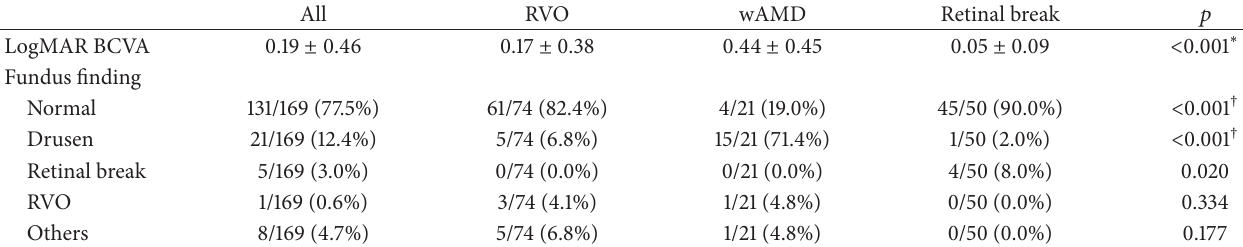
Table 3: Findings in the fellow eye of acute-onset vitreous hemorrhage (VH) of preoperatively unknown origin. All RVO